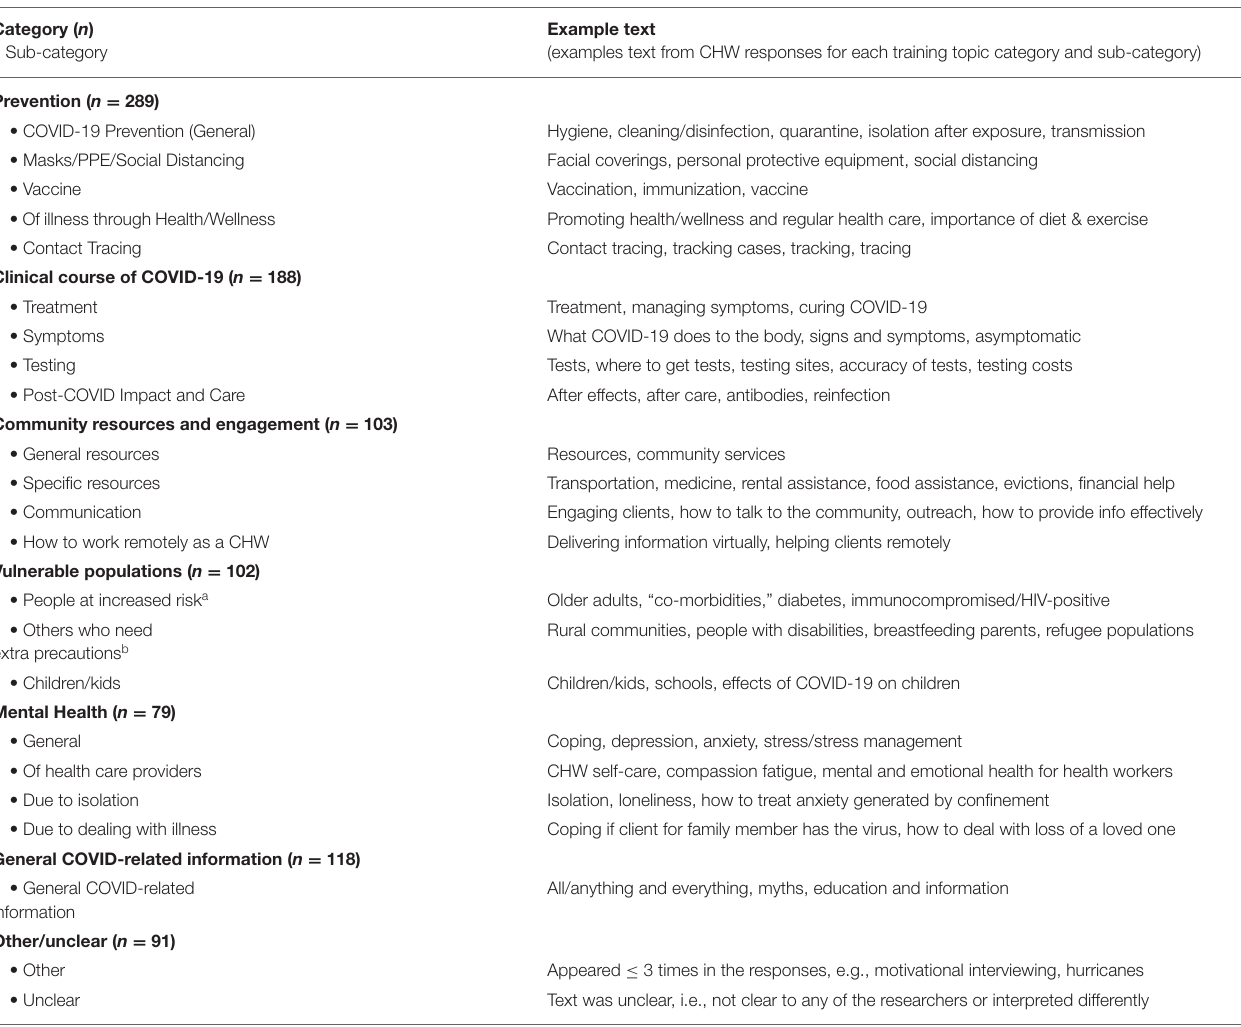
TABLE 2 | Categories & sub-categories of training topics related to COVID-19 requested by Community Health Workers (CHWs). Category ( n ) •